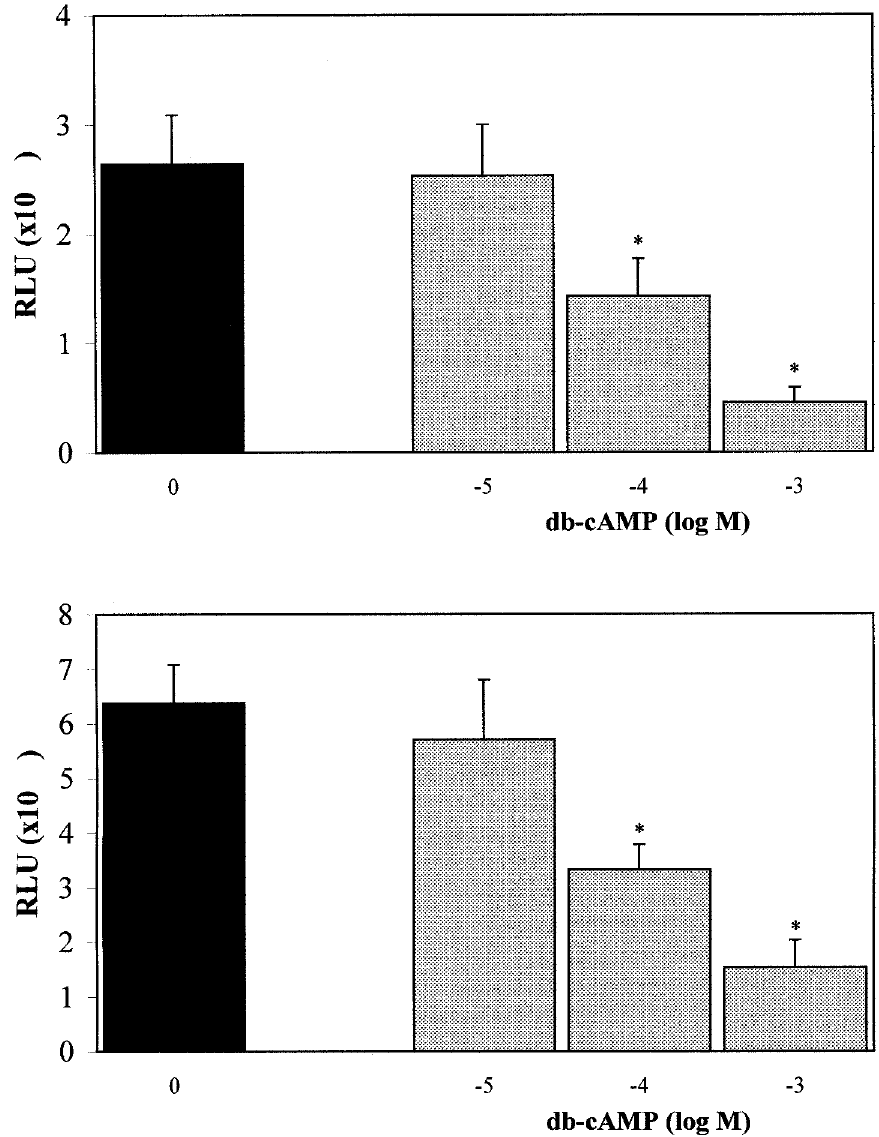
FIG. 3. Effects of dibutyryl-cyclic AMP (db-cAMP) (10 –5 to 10 –3 M) or vehicle on fMLP-induced increased in superoxide anion production (expressed in relative light units (RLU)) from peripheral blood mononuclear cells pretreated (lower panel) or not (upper panel) with lipopolysaccharide. * p < 0.05, ** p < 0.01 in comparison with non-treated (control) cells ( n =